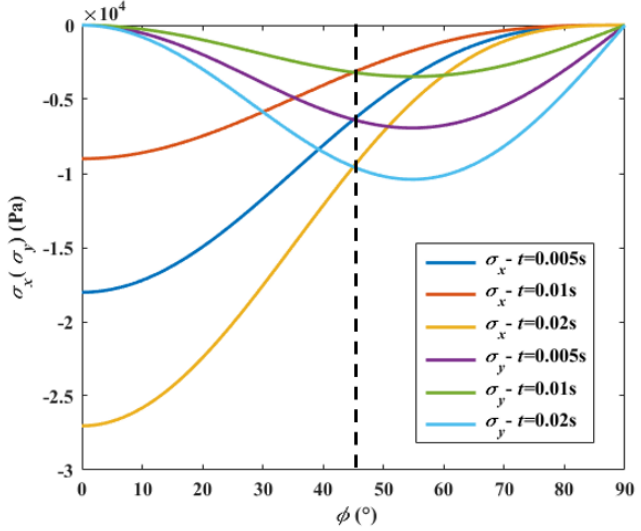
Figure 4. Variation curve of far-field stress with crack rotation angle ϕ at different moments.